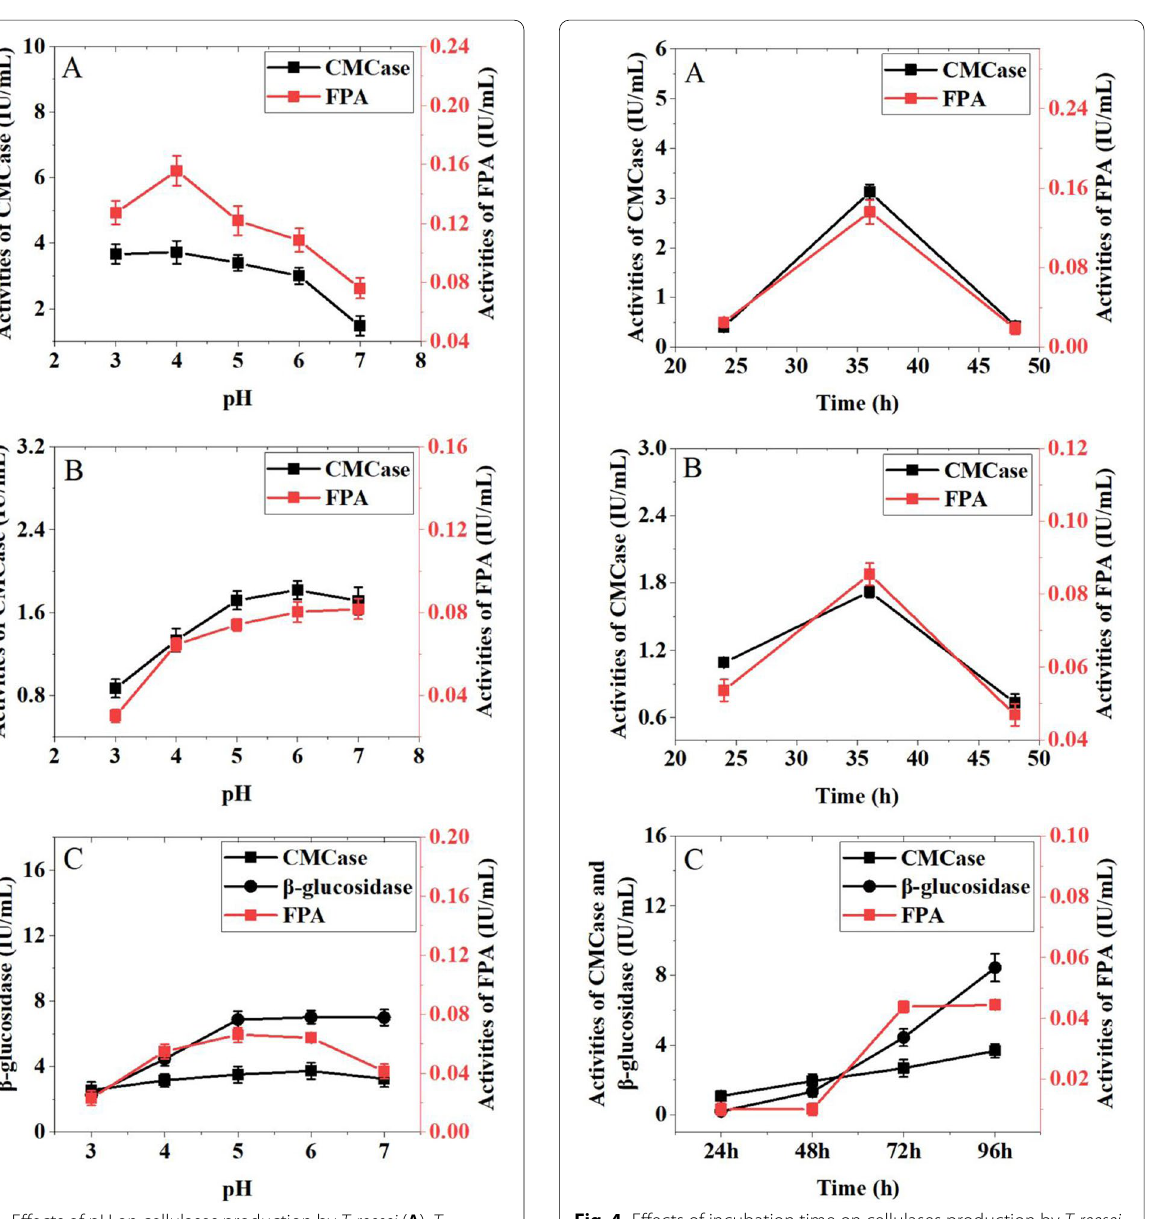
Fig. 3 Effects of pH on cellulases production by T. reesei ( A ), T. harzianum ( B ) and A. niger ( C )